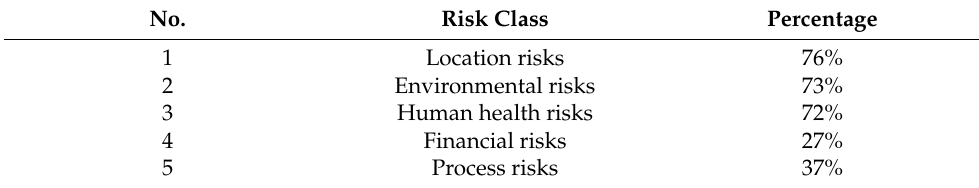
Table 3. Perceived risks about the establishment of the Gunnedah waste